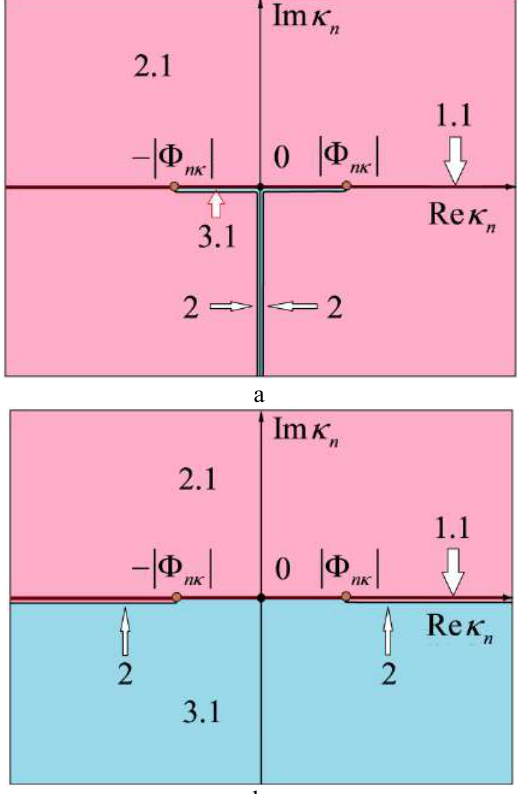
Figure 3: Variants of physical sheets of the Riemann manifolds , , with the branch points and cuts along (а) segments of the real and imaginary axes, (b) imaginary semi-axes;